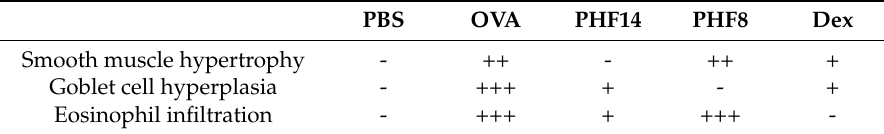
Table 1. Degree of airway remodeling of the